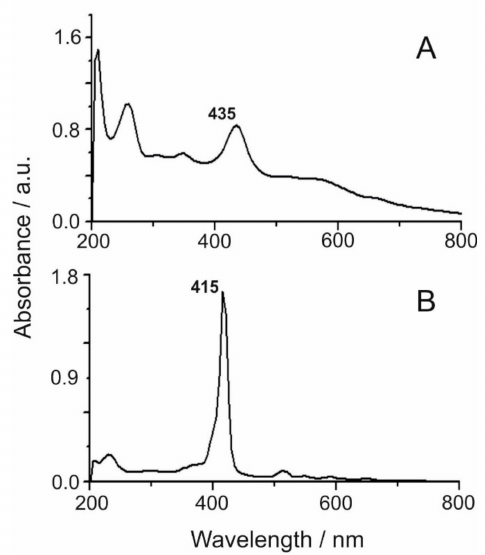
Figure 1. UV-Vis absorption spectra of ( A ) TDAP and ( B ) TCPP in ethanol.